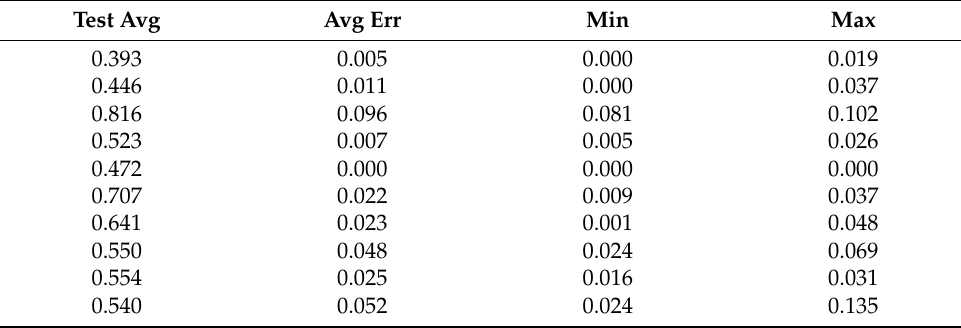
Table A161. Set 3, trials 1–10 data (single 0.5 PR